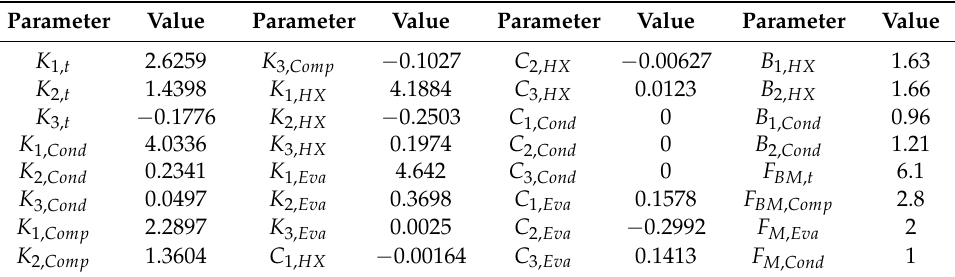
Table 6. Constant values of cost correlation in Table 5